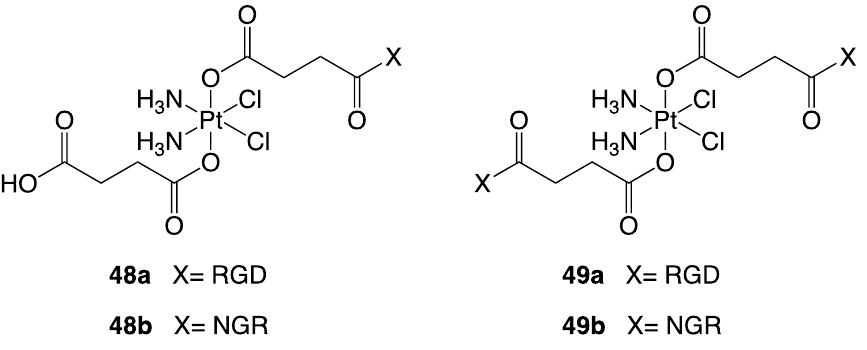
Figure 31. Structures of compounds 48a – b and 49a – b .